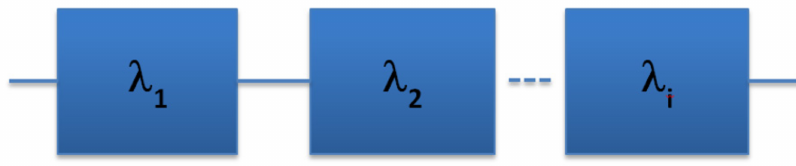
Figure 9. Series or weakest link failure system model.